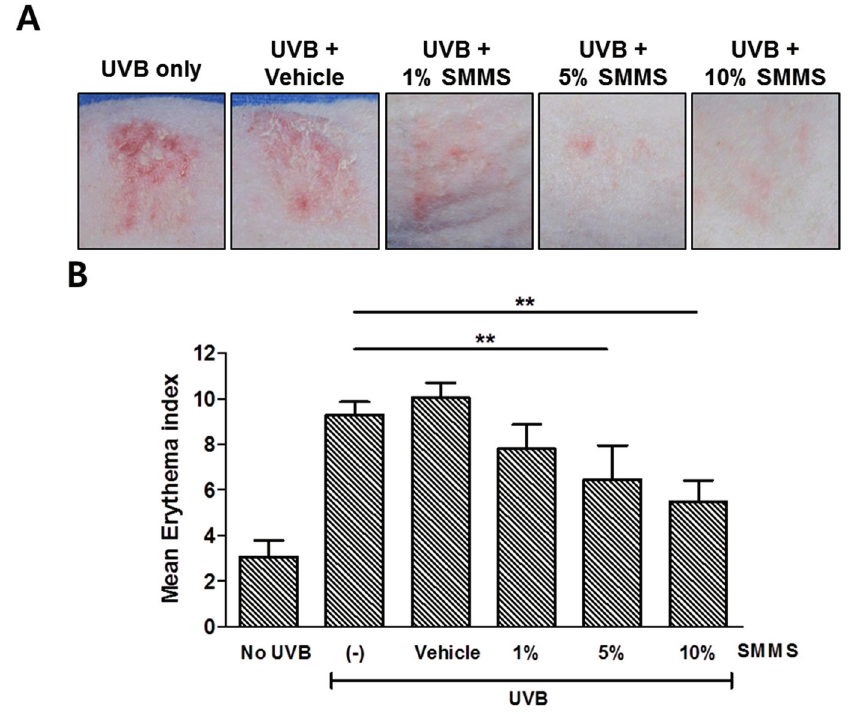
Figure 3. Photoprotective effect of SMMS in hairless albino rats. Erythema was induced by UVB irradiation (2× minimal erythema dose (MED)) on the backs of hairless albino rats. Before and immediately after UVB irradiation, we applied topically 1%, 5%, and 10% SMMS mixture to the right side of three rats, respectively ( n = 3 for each group). ( A ) The photographs show the rats’ skin 72 h after UVB irradiation. Scale bars = 1 cm; ( B ) Erythema index was measured using spectrophotometry 72 h after ultraviolet B irradiation. Application of 5% and 10% SMMS significantly reduced the UVB-induced skin erythema. (-) stands for UVB-irradiated control. All values are presented as a mean ± standard deviation. ** p <